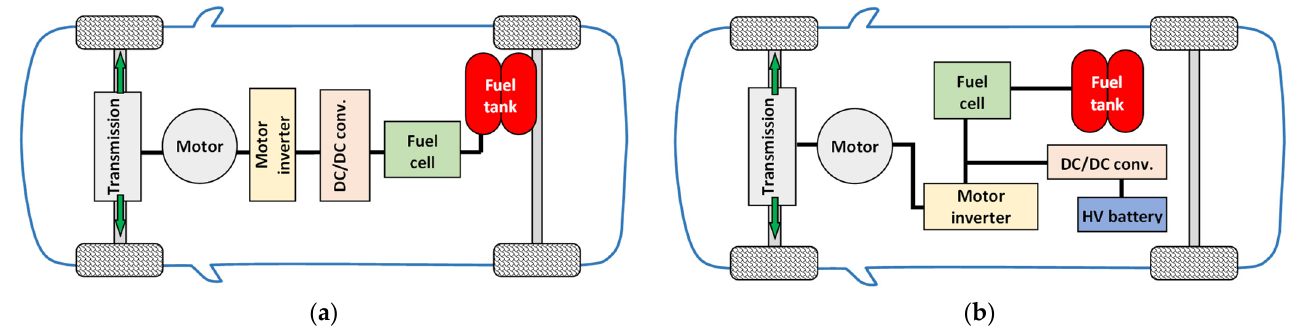
Figure 2. Drive system diagrams employing fuel cell technology: ( a ) FCEV; ( b ) FCHEV (based on [4]).